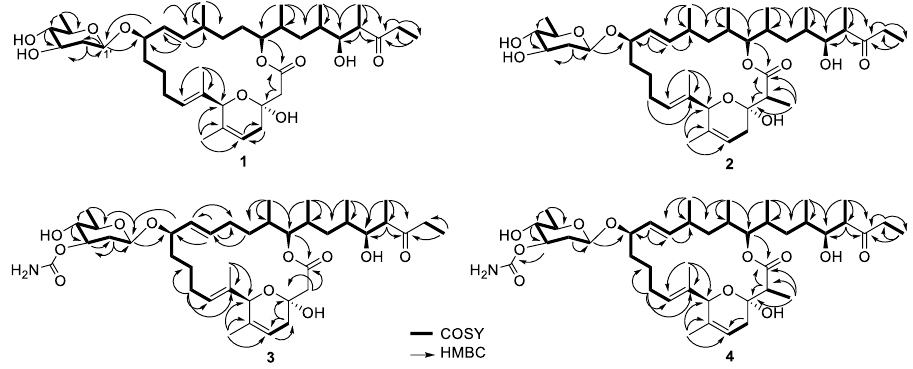
Figure 2. 2D NMR correlations of compounds 1 – 4 . 2D NMR: two-dimensional nuclear magnetic resonance.